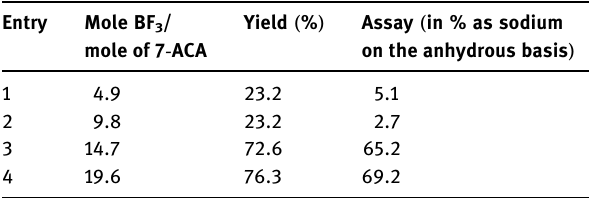
Table 1: E ff ects of equivalents of the 16% BF 3 /CH 3 CN complex